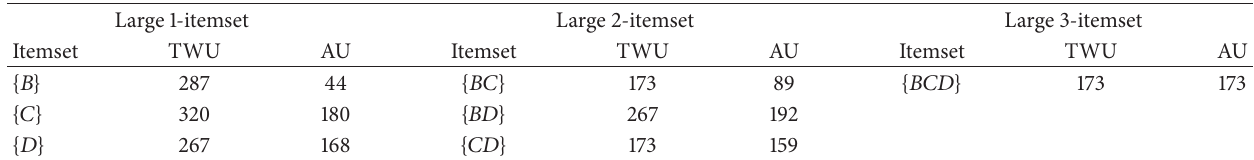
Figure 5: The set of sensitive high utility itemsets that fail to be hidden. Table 9: The large transaction-weighted utilization itemsets.